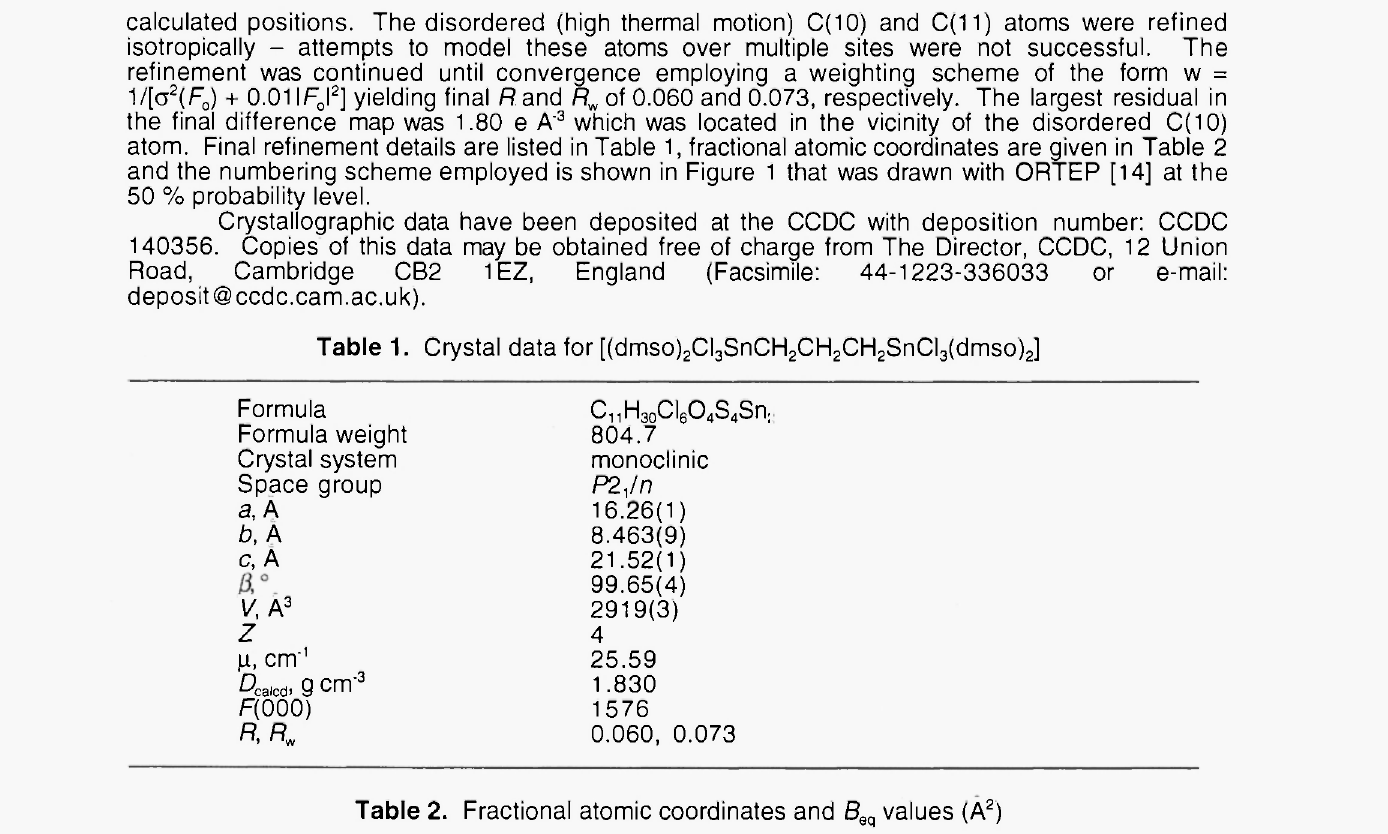
Table 2. Fractional atomic coordinates and 8 eq values (A 2